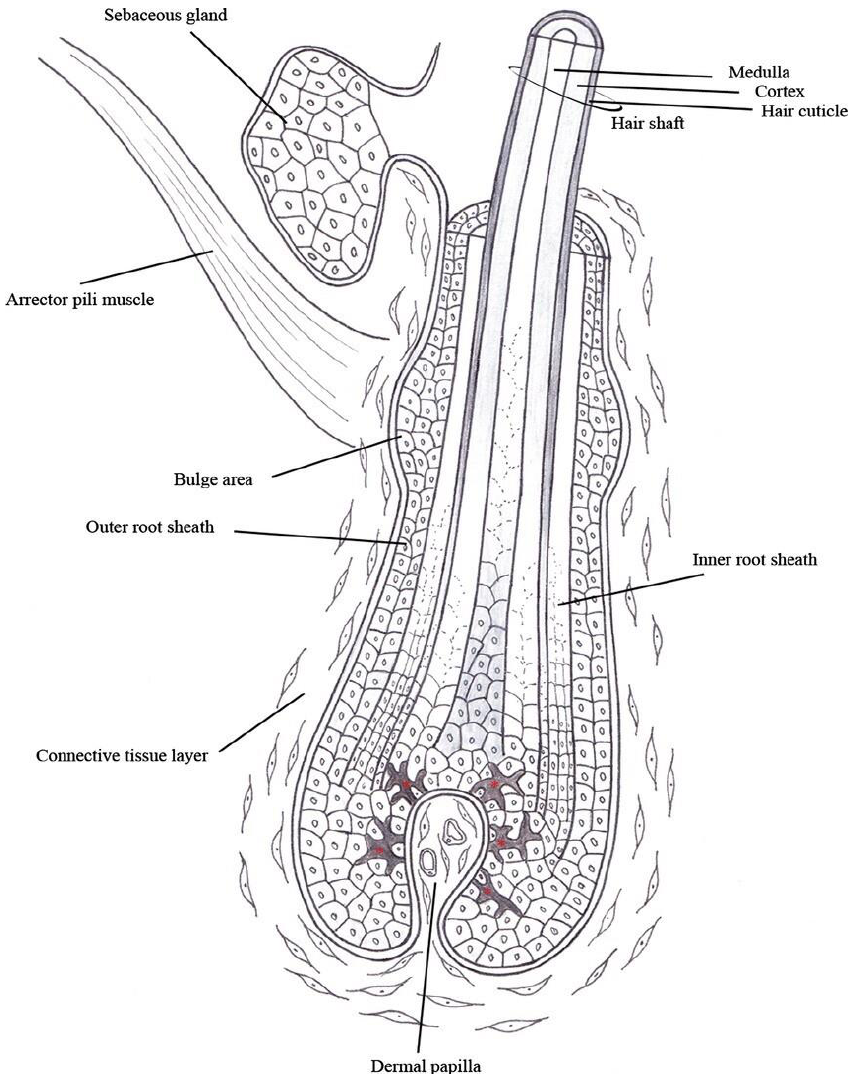
Figure 1. The Hair structure “Reprinted with permission from Ref. [ The human hair: From anatomy to physiology. Int. J. Dermatol.] 2013, Buffoli, B.; Rinaldi, F.; Labanca, M.; Sorbellini, E.; Trink, A.; Guanziroli, E.; Rezzani, R.; Rodella, L.F. et al. [1].